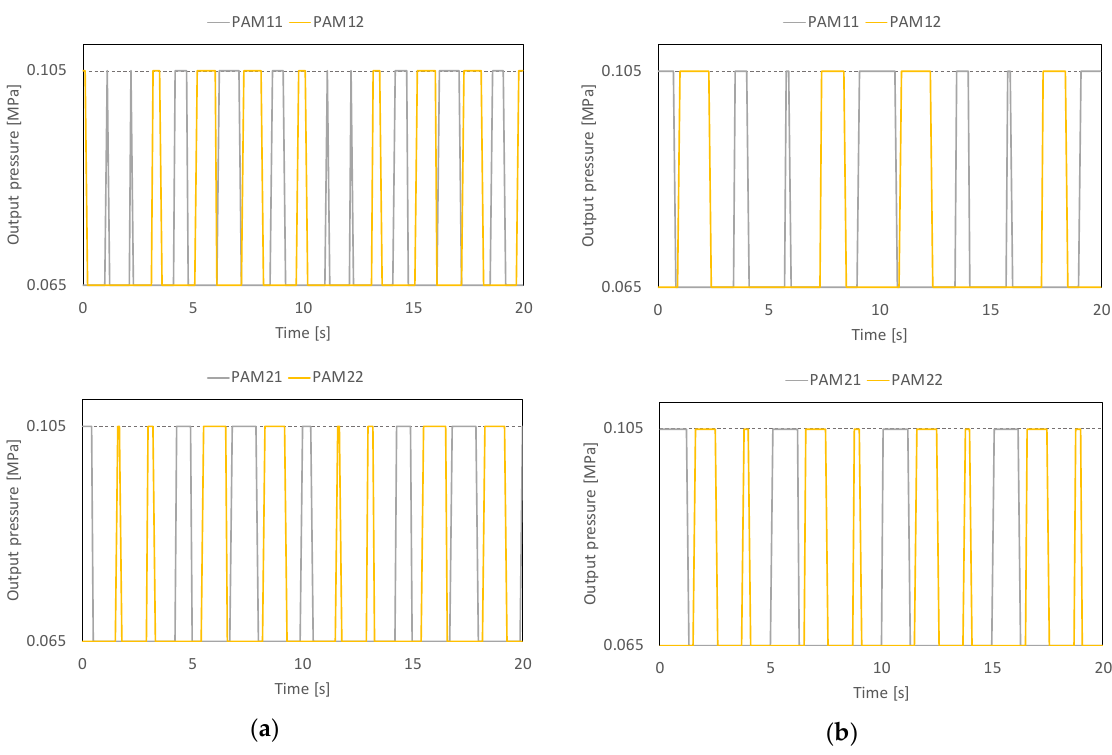
Figure 17. Cyclic inputs of PAMs using evaluation function 1 with 0.5 kg (( a ) first generation, ( b ) 18th generation).